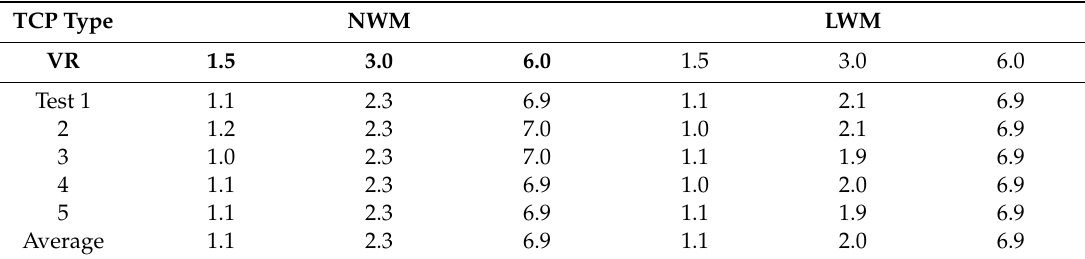
Table 5. Visible light transmittance (VLT) of the TCPs (%).